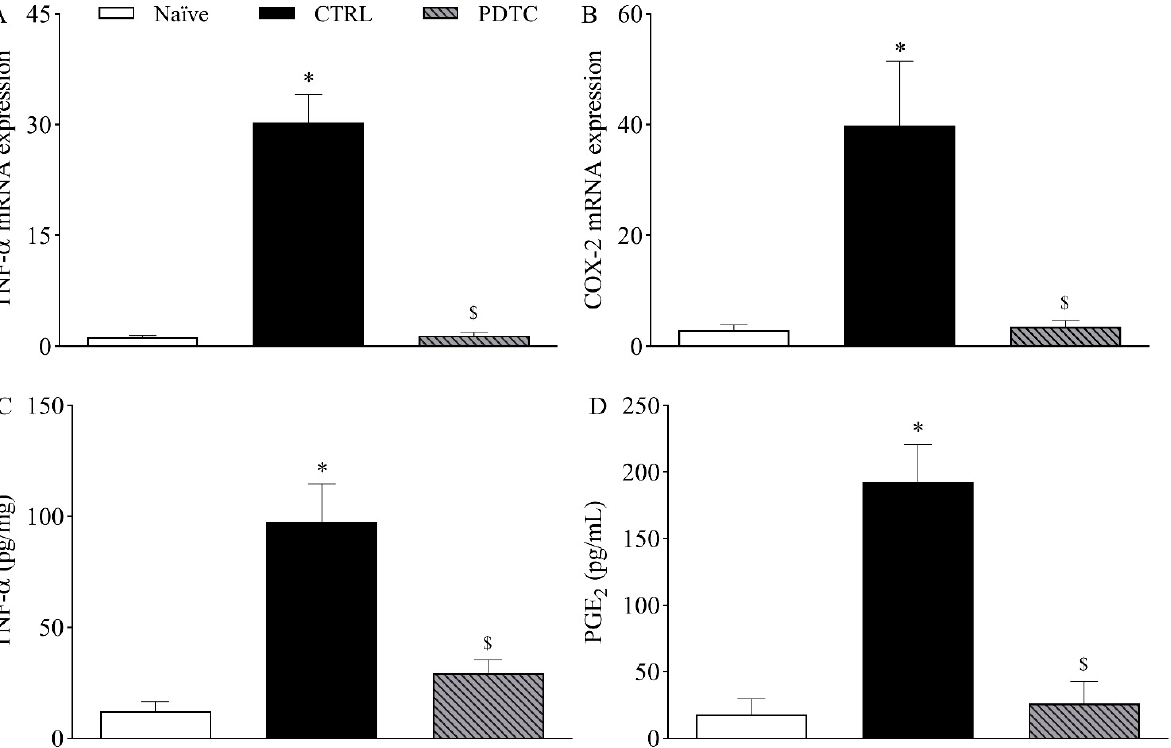
Figure 6. Influence of NF- κ B on the expression of TNF- α and COX-2 /PGE 2 following plantar incision. Mice were treated with the NF-kB antagonist PDTC (100 mg/kg, intraperitoneally) or the vehicle (CTRL; control group) one hour before the induction of the plantar incision model of postoperative pain. No surgical procedures were performed on naïve mice. ( A , B ) The levels of TNF- α mRNA ( A ) and COX-2 mRNA ( B ) in the DRG (axis of ordinates) were determined by Real-Time PCR one day after plantar incision. Target gene expression (2 − ∆∆ Ct ) was determined using Gapdh as housekeeping gene. Data are expressed as means ± SD ( n = 6). * p < 0.05 compared with naïve group. $ p < 0.05 compared with CTRL group. One-way ANOVA followed by Tukey’s test. ( C , D ) The levels of TNF- α ( C ) and PGE 2 ( D ) in the plantar skin of the incised paw (axis of ordinates) were quantified one day after plantar incision. Data are expressed as means ± SD ( n = 6). * p < 0.05 compared with naïve group. $ p < 0.05 compared with CTRL group. One-way ANOVA followed by Tukey’s test.